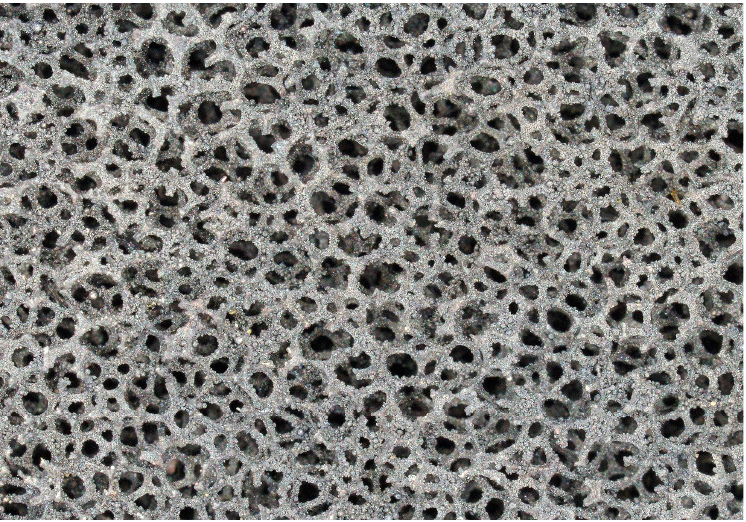
Figure 3. Multiple cycle preparation process with 5% sodium permanganate solution (sample P2S1—triple process with 5% solution of NaMnO 4 ).